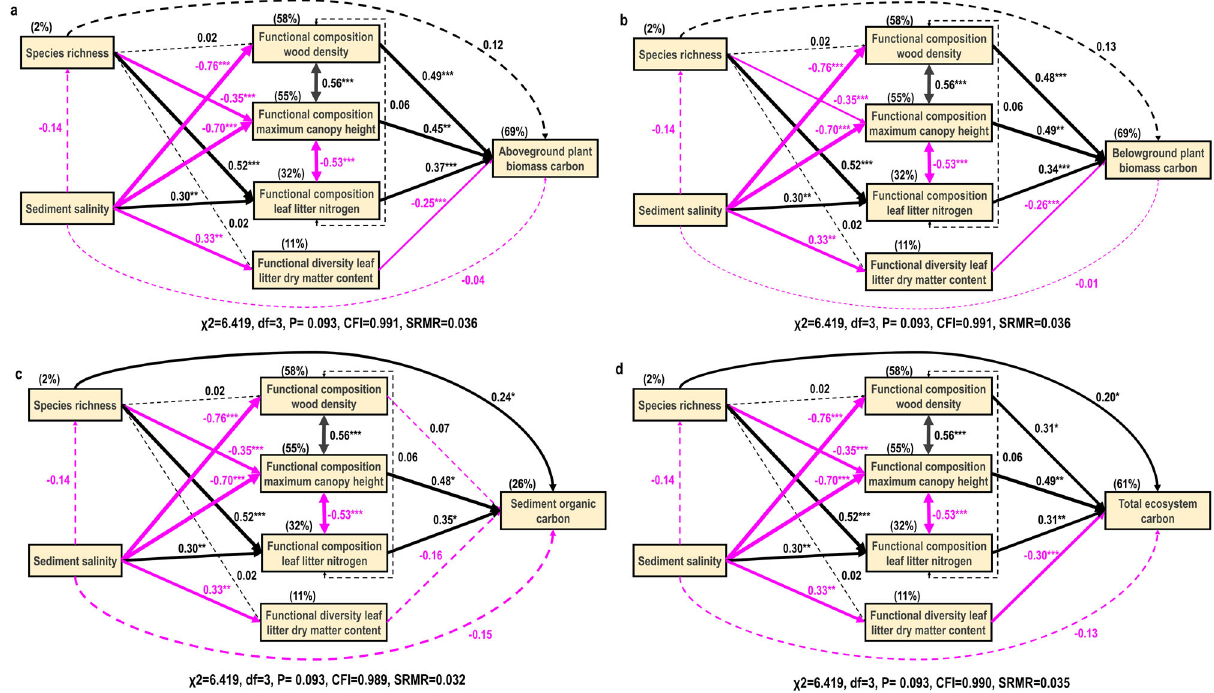
Fig. 3 Structural equation models (SEMs) for understanding the diversity association with blue carbon storage. a – d Aboveground plant biomass carbon ( a ), Belowground plant biomass carbon ( b ), Sediment organic carbon ( c ), and Total ecosystem carbon ( d ). All four SEMs had a similar nonsigni fi cant χ 2 (Chi-Square) of 6.83 ( P = 0.093) with a comparative fi t index close to one (CFI; 0.99) and standardized root mean square residual close to zero (0.036) indicating no signi fi cant deviation from model and datasets at 3 degree of freedom. The lines with pink and black indicate a negative and positive association between the two covariables. Arrows with numbers indicate the standardized association of predictors with dependent variables. Numbers with percentages above boxes independent variables indicate their explained variance (Coef fi cient of determinant: R squared) by all the predictors. The paths value with star mark indicate their signi fi cance level (***: P < 0.001, **: P < 0.01, *: P < 0.05) while the insigni fi cant paths were indicated as dotted line ( P > 0.05).